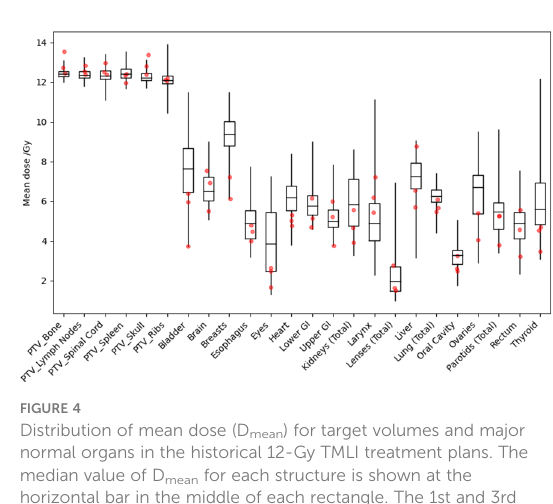
FIGURE 3 Distribution of mean dose (D mean ) for target volumes and major normal organs in the 20-Gy cohort. The median value of D mean for each structure is shown at the horizontal bar in the middle of each rectangle. The 1st and 3 rd quartiles are shown as the lower and upper horizontal sides of each rectangle. The minimum and maximum range of D mean is shown as the vertical lines extending from each rectangle.